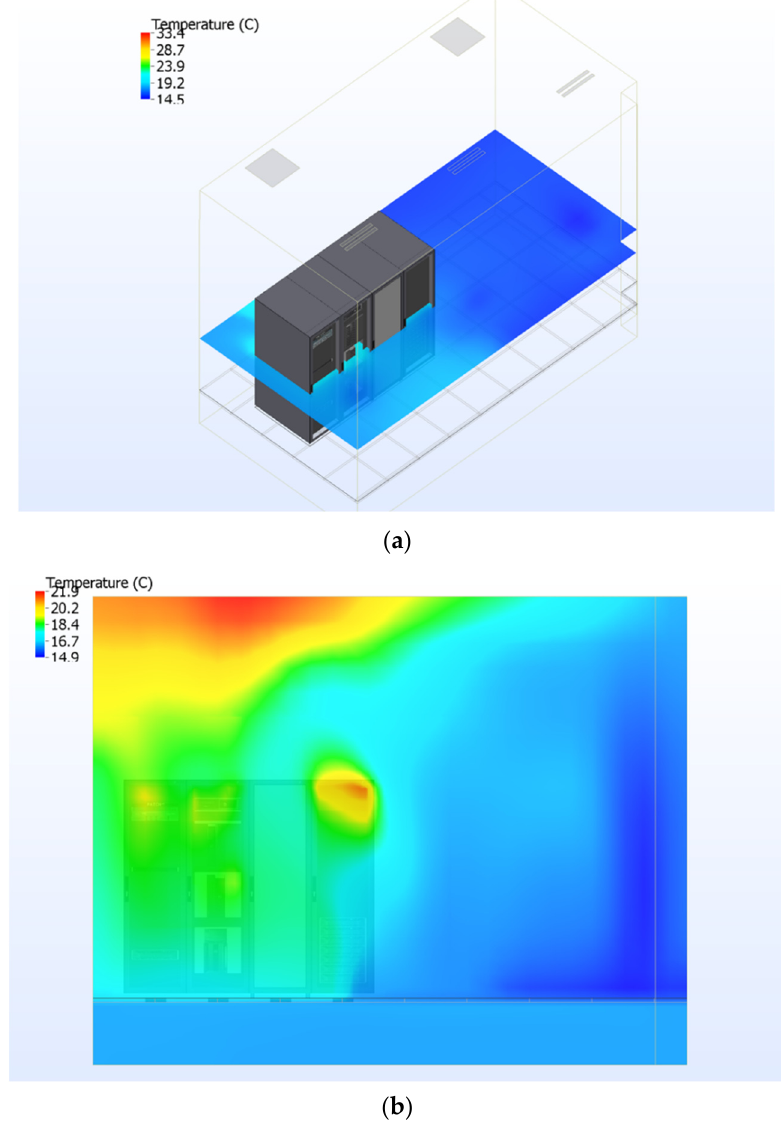
Figure 2. Baseline model temperature distribution: ( a ) isometric view; ( b ) server rack inlet.